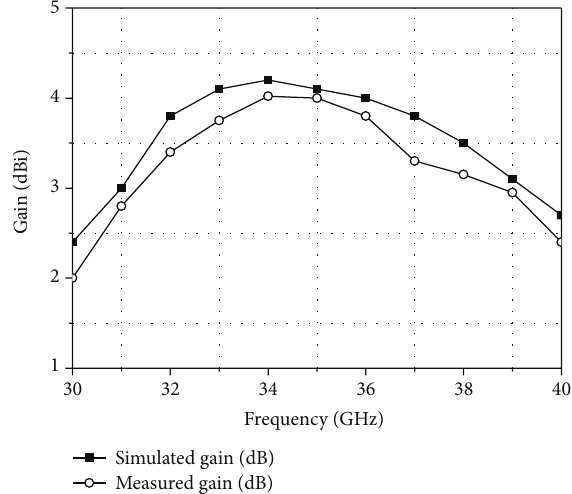
Figure 5: Simulated and measured gain of the proposed antenna.